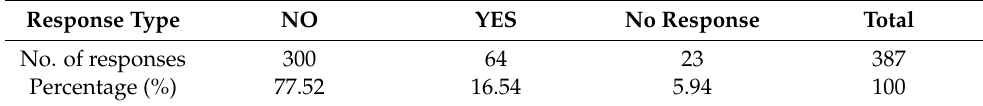
Figure 1. Responses to the seventh question: Can you name any cryptocurrencies? If so, please do. When asked in the eighth question whether they had a portfolio of cryptocurrencies, 23 respondents (approx. 6%) decided to remain silent. Of the others, 64 (approx. 16.5%) declared some portfolio. The remainder (77.5%) did not have any cryptocurrencies (Table 7). Table 7. Responses to the eighth question: Do you have a cryptocurrency portfolio?